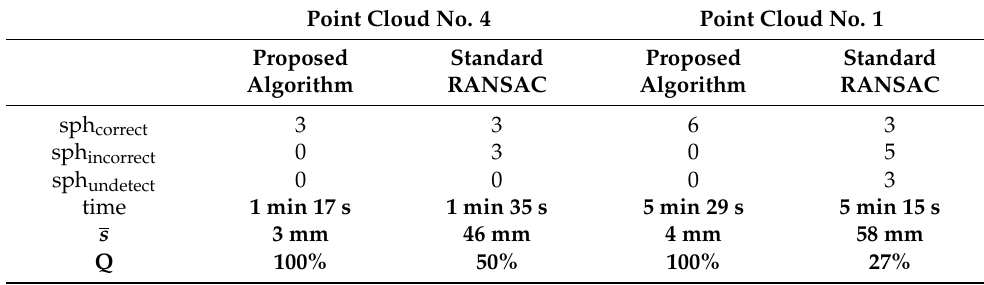
Table 4. Qualitative characteristics of sphere